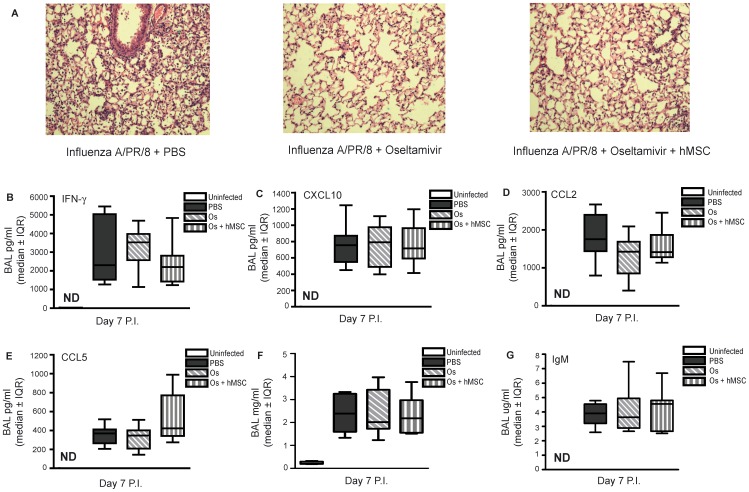
hMSC adjunctive therapy failed to decrease pulmonary inflammation or prevent ALI compared to antiviral therapy alone in experimental severe influenza.Eight-week old male C57Bl/6 mice infected with 425 EID50 influenza A/PR/8 virus were administered 2.5 mg/kg oseltamivir in 100 ul ddH2O via gavage, 1×daily for 5 days, beginning day 2 P.I., with or without hMSC administration (5×105 cells) on day 2 P.I. and sacrificed on day 7 P.I. (A) Representative images of hematoxylin and eosin stained lung sections. Oseltamivir treated mice demonstrate decreased inflammatory cell infiltrates in the lung compared to untreated infected control mice. However, mice administered hMSCs and oseltamivir in combination demonstrate similar cellularity and lung injury to mice administered oseltamivir alone. (B–E) No significant difference in BAL fluid level of cytokines and chemokines (IFN-γ, CXCL10, CCL2 or CCL5) was observed for mice administered oseltamivir and hMSCs in combination, compared to mice administered oseltamivir alone (one-way ANOVA, n = 8–10/group, representative of 2 independent experiments). (F,G) No significant difference in markers of ALI (total protein or IgM) was observed for mice administered oseltamivir and hMSCs in combination, compared to mice administered oseltamivir alone (one-way ANOVA, n = 8–10/group, representative of 2 independent experiments). Error bars represent interquartile range (IQR). ND = nondetectable; Os = oseltamivir.